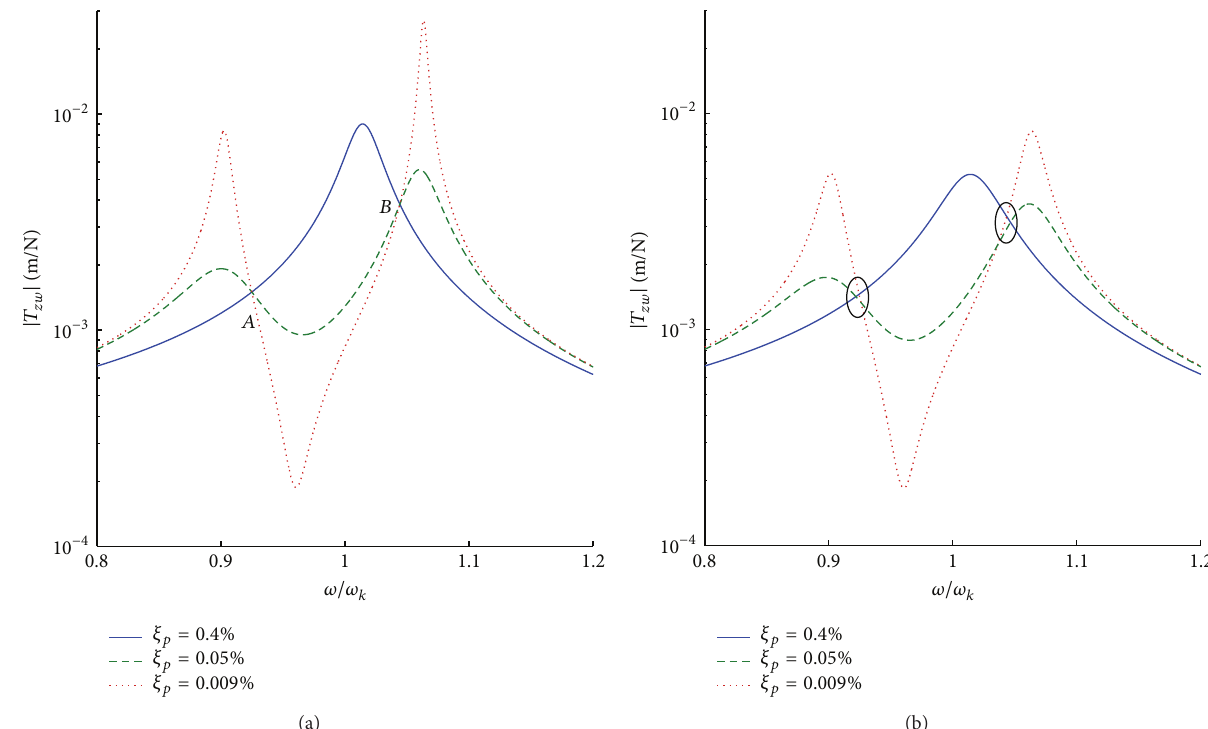
Figure 9: |𝑇 𝑧𝑤 | for (a) undamped elastic structure and (b) damped elastic structure: 𝜉 𝑘 = 1